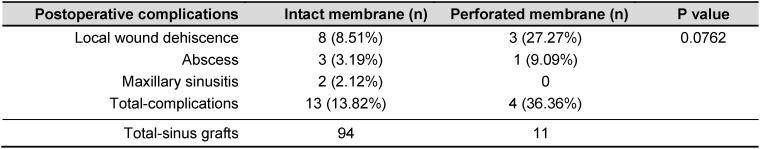
Membrane integrity at augmentation procedures with postoperative complications